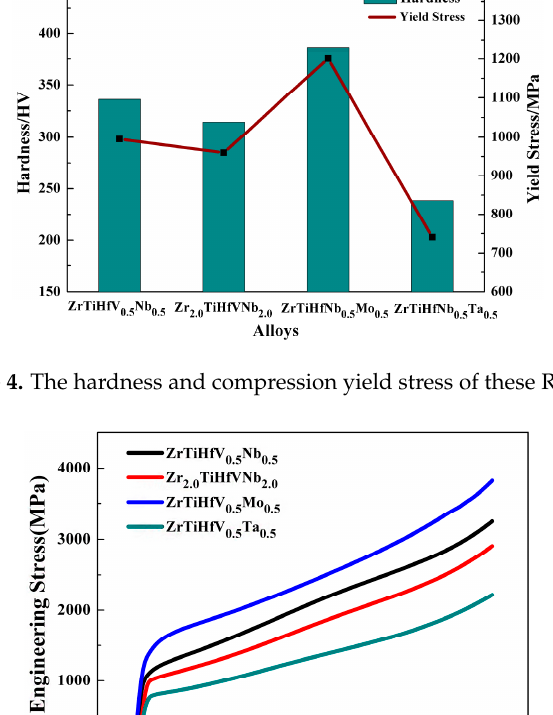
Figure 4. The hardness and compression yield stress of these RHEAs.